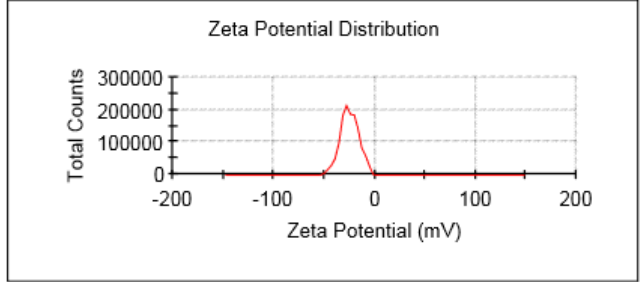
Fig. 2. Analysis of the zeta potential of the MTX loaded PLGA nanoparticle (-24.6